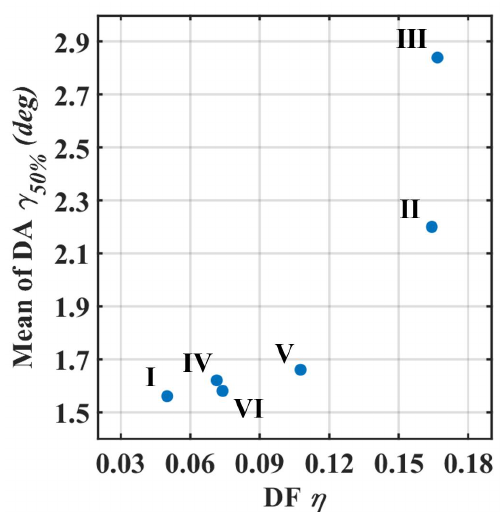
Figure 6. Relationship between the divergence angle and the dimensional factor for each commercial UV-LED light source after light